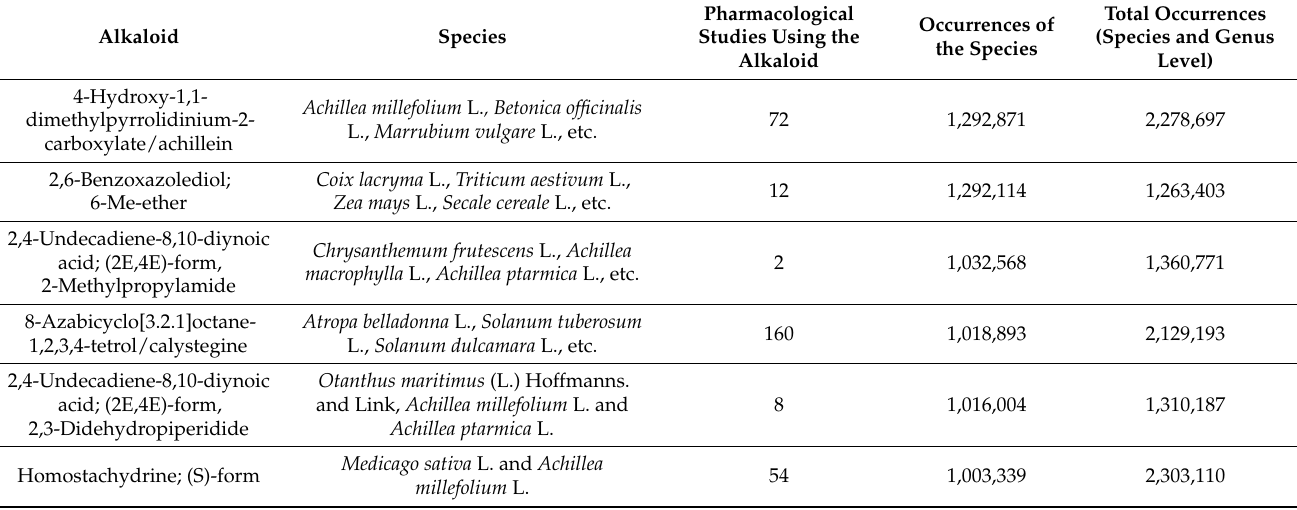
Table 3. Examples of alkaloids and source species with over one million total occurrences in the GBIF. A source species is only included if it is identified botanically with the species level in the DNP and data on the genus level and above are excluded. Therefore, these are examples of simple alkaloids surpassing 1 million total occurrences and do not account for all examples. Occurrences collected at genus level include those for species. Pharmacological study references of alkaloids are queried on the chemical abstract service